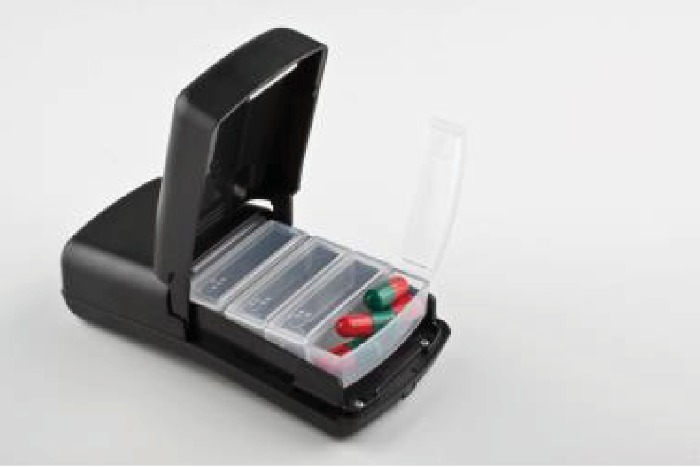
The Wisepill device.